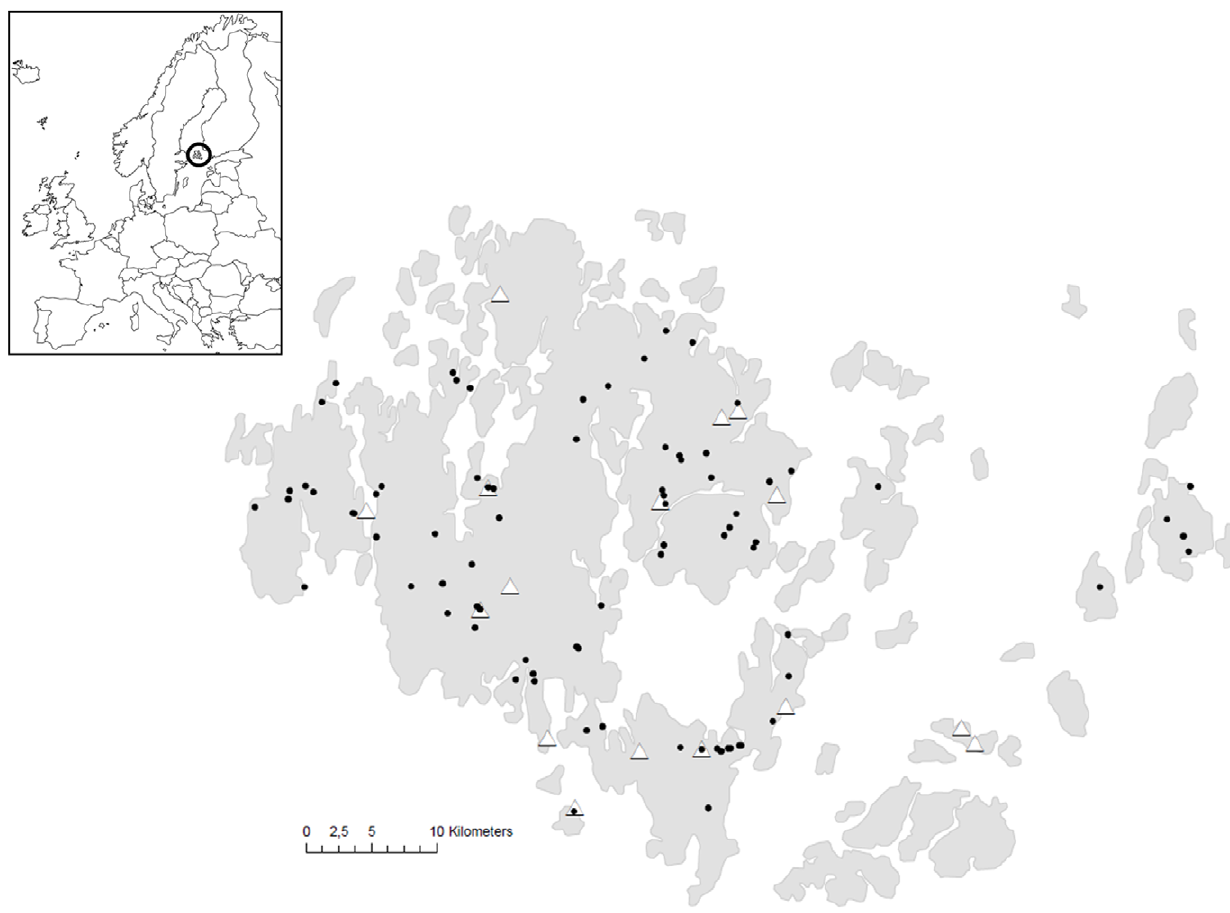
Figure 1. Sampling location within the A˚land archipelago. The location of the 16 Po. plantaginis sampling sites for the pooled 454 RNA sequencing is represented with white triangles and the location of the 80 sampling sites for the genotyping dataset used for SNP validation is represented with black circles.